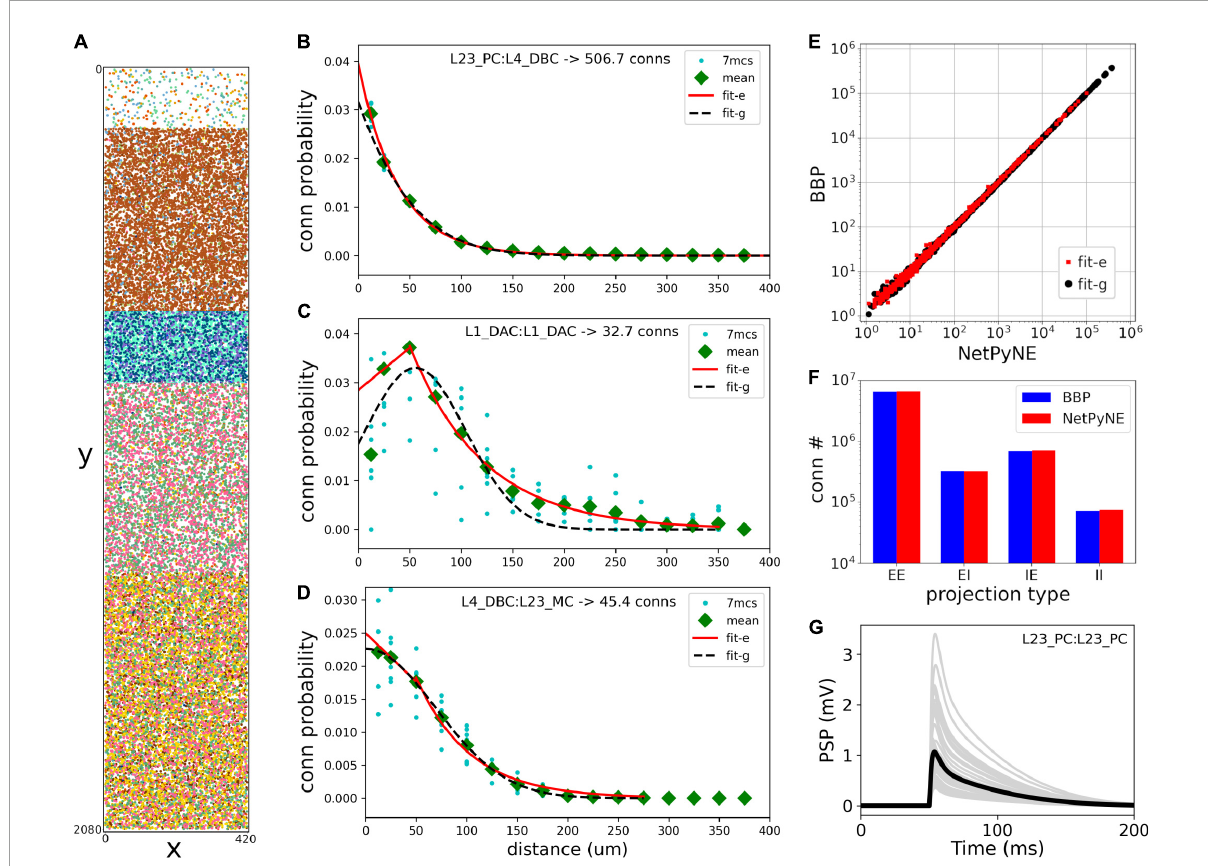
FIGURE2 Reproduction and validation of BBP S1 neuron distribution and connectivity in NetPyNE. (A) 2D representation of the location of 31,346 cells in a cylinder with 2,082 µ m height and 210 µ m radius, with each subtype (different colors) randomly distributed within its layer (L1, L2/3, L4, L5, or L6). (B–D) Probability of connection as a function of neuron pairwise 2D distance for three example pathways, each with a different best fit function: a single exponential ( B , red line), exponential with a linear saturation rule ( C , red line), and single gaussian fit ( D , black dashed line). Cyan circles represent data from 7 microcircuit instances, and green diamonds represent the mean across the 7 instances. (E,F) Comparison of the number of connections between NetPyNE and BBP for each of the 1,941 pathways (E) and 4 projection types (p-types) (F) . (G) Postsynaptic potential (PSP) generated by connection between L23_PC neurons ( Table 1 , #18) simulated in NetPyNE; mean PSP trace (black line) across 20 PSP random instances (gray lines).